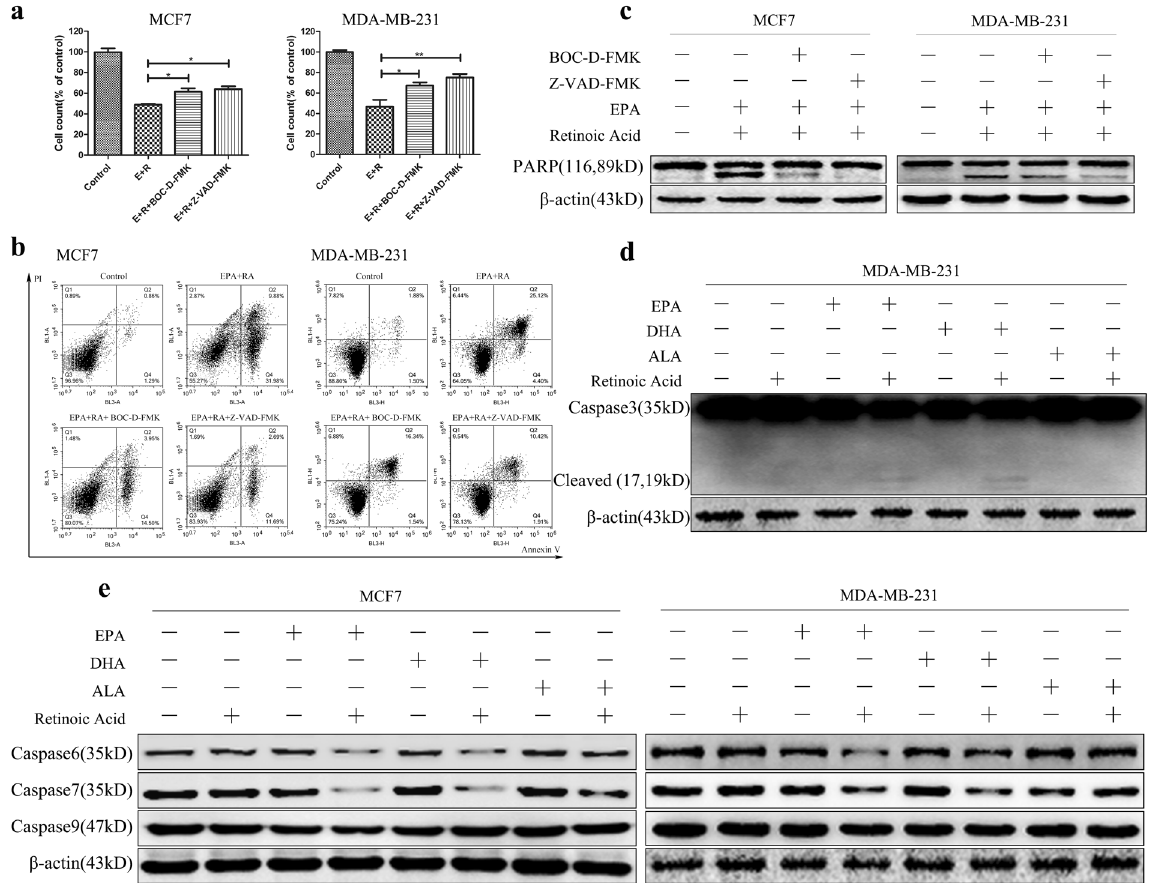
Figure 5. Caspase signaling pathway. MCF7 and MDA-MB-231 cells were pretreated with 10 µ M Z-VAD-FMK and BOC-D-FMK for 1 h and then exposed to 80 μ M ω 3-FFAs and 20 μ M ATRA for 48 h. ( a ) Cell counting assays. ( b ) Cell apoptosis was analyzed by flow cytometry with PI and Annexin V-FITC staining. ( c ) The expression of PARP protein. ( d ) The expression of Caspase-3 protein. ( e ) The expression of Caspase-6, -7 and -9 protein. β -Actin was used as an internal control. Values represent the mean ± SD (n = 3). * P < 0.05; ** P < 0.01; *** P <